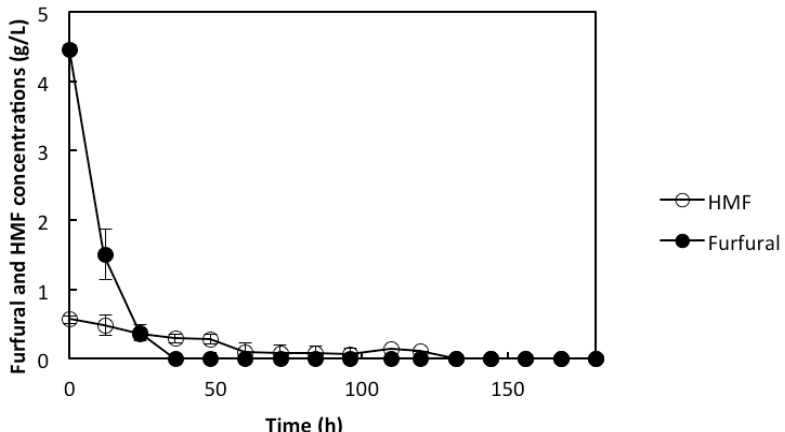
Figure 5. Concentration (g/L) profiles of furfural and HMF during the use of rMBR in the liquid fraction of prehydrolyzed pretreated wheat straw used as xylose-rich lignocellulosic material. Presented values are average values of two experiments, with error bars as the standard deviation between the two